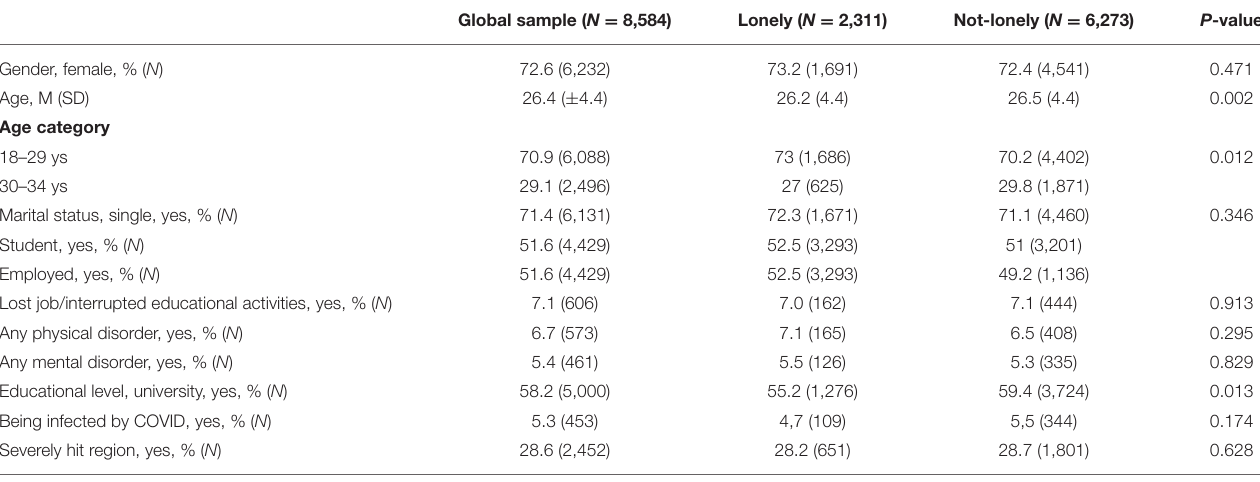
TABLE 1 | Socio-demographic characteristics of the sample ( N = 8,584).